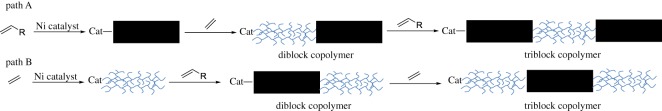
Sequential addition of monomer strategy.